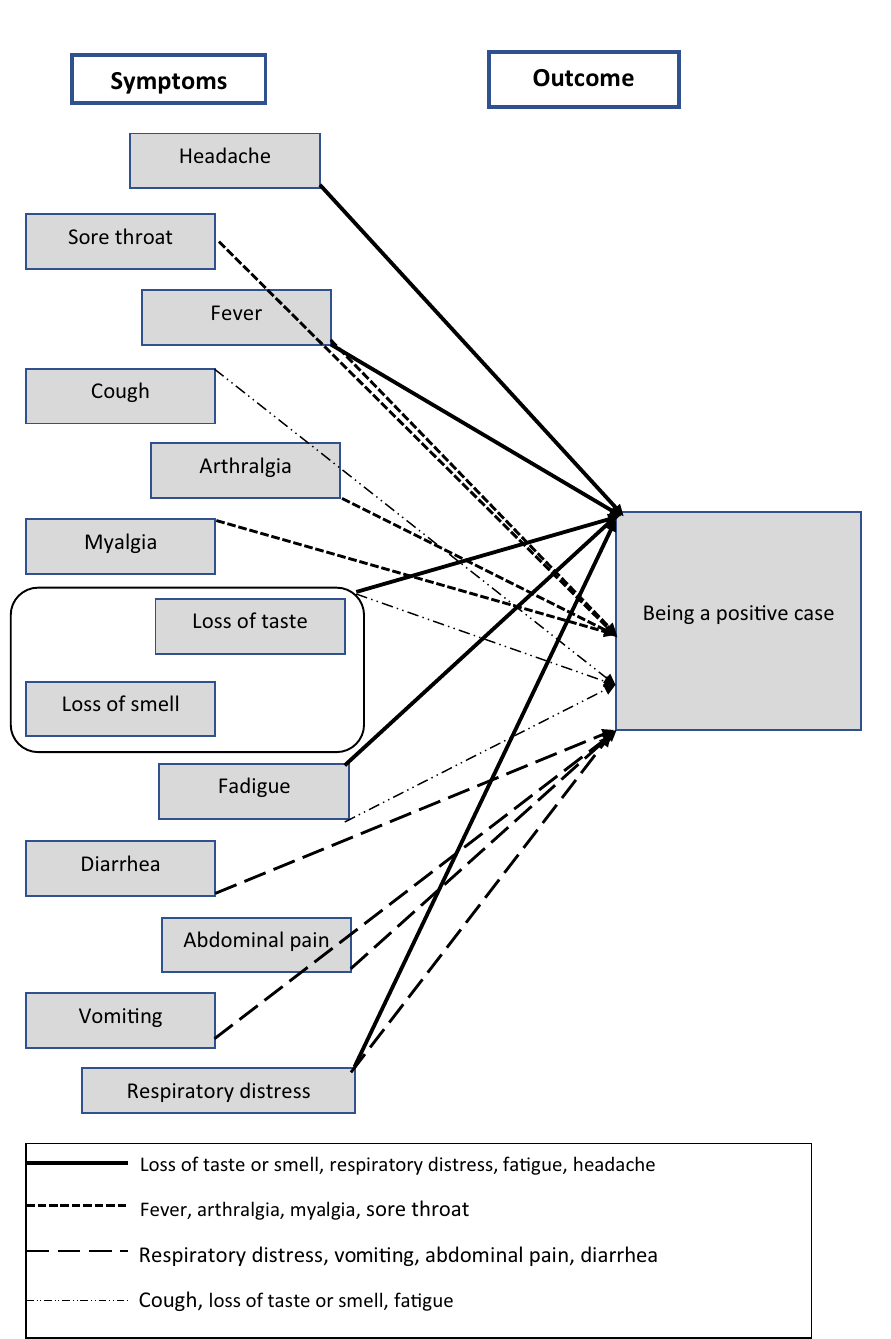
Figure 1. Study hypothesis about the set of symptoms associated with